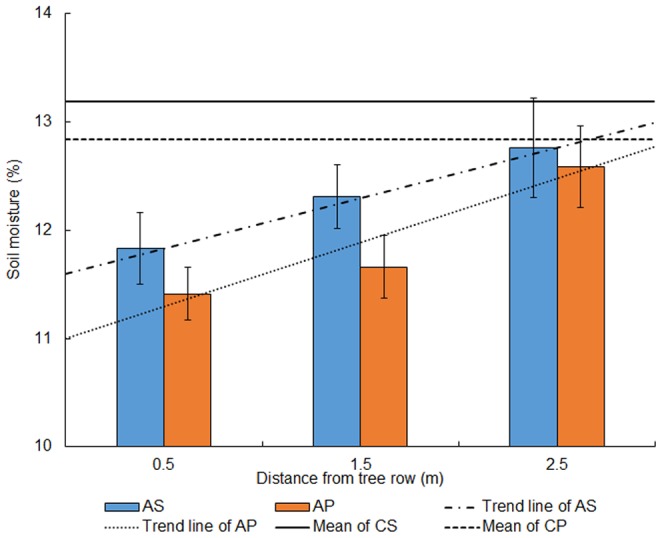
Soil moisture of 0 to 100 cm depth for the intercropping systems and its control.Vertical lines indicate confidence interval at 95% level.